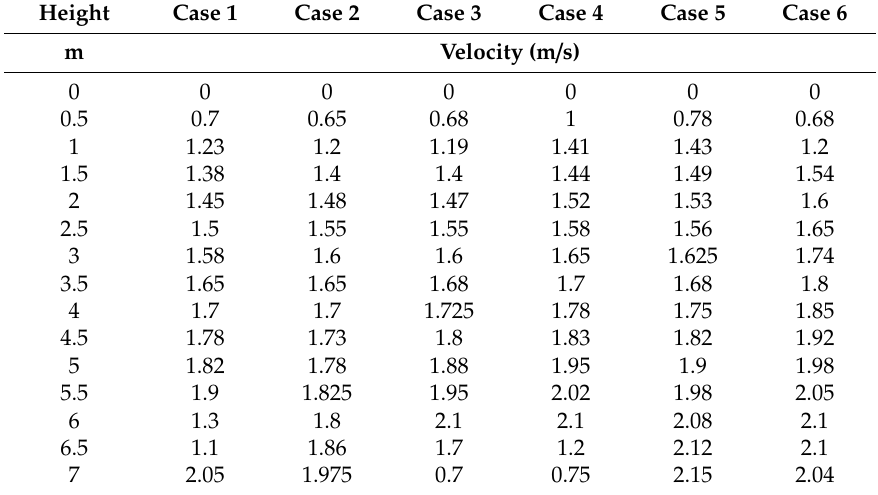
Table 5. Simulated mean wind velocity outcomes for each case along the 7 m vertical profile.